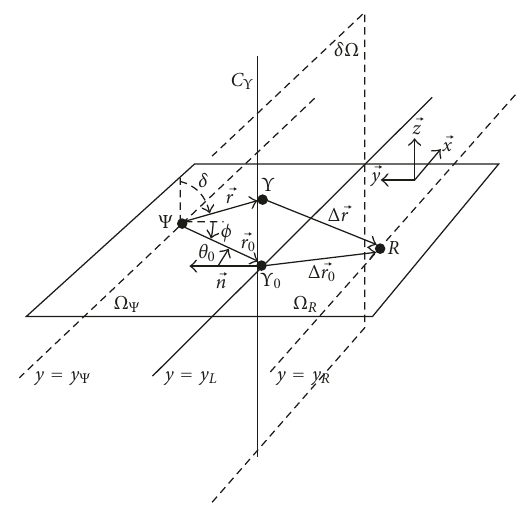
Figure 1: Synthesis of the sound field emitted by Ψ using the Rayleigh 1